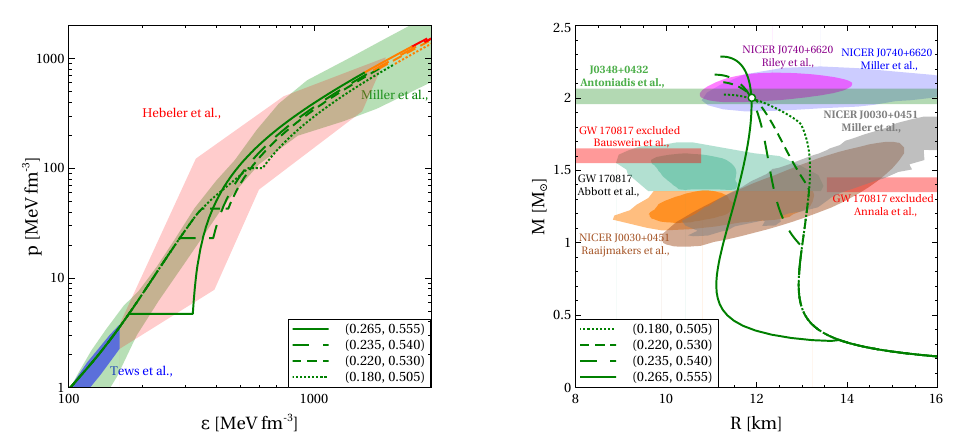
Figure 4. The same as in Fig. 1 but for the confining RDF approach and the hypernuclear EoS DD2Y-T replacing the nlNJL quark matter EoS and the nonstrange hadronic EoS DD2p00 and DD2p40, resp. The pair of values given in brackets in the legends stands for ( η V ,η D ). Figure taken from Ivanytskyi & Blaschke in these